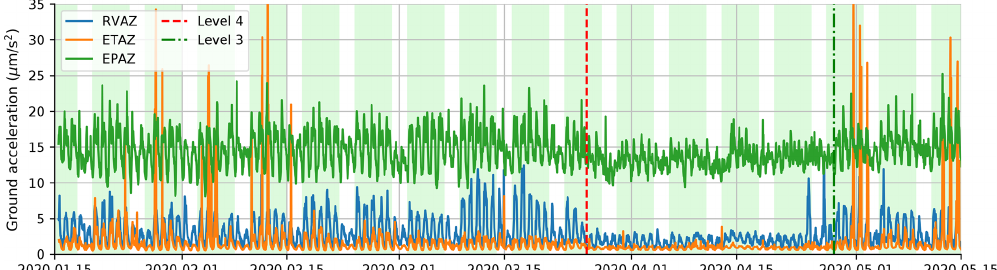
Figure 5. RSAM levels for three other borehole stations of the AVSN closest to the Auckland CBD are reduced during the